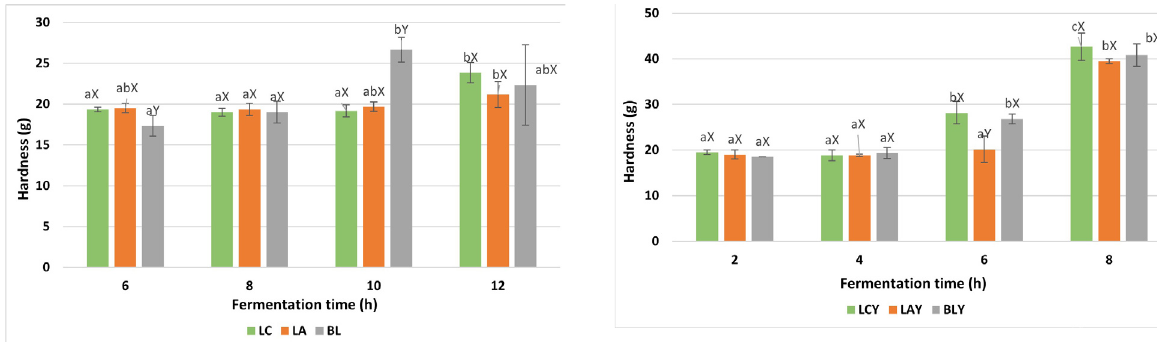
Figure 2a. Hardness values of LC, LA and BL samples during the fermentation. Figure 2b. Hardness values of LCY, LAY and BLY samples during the fermentation.